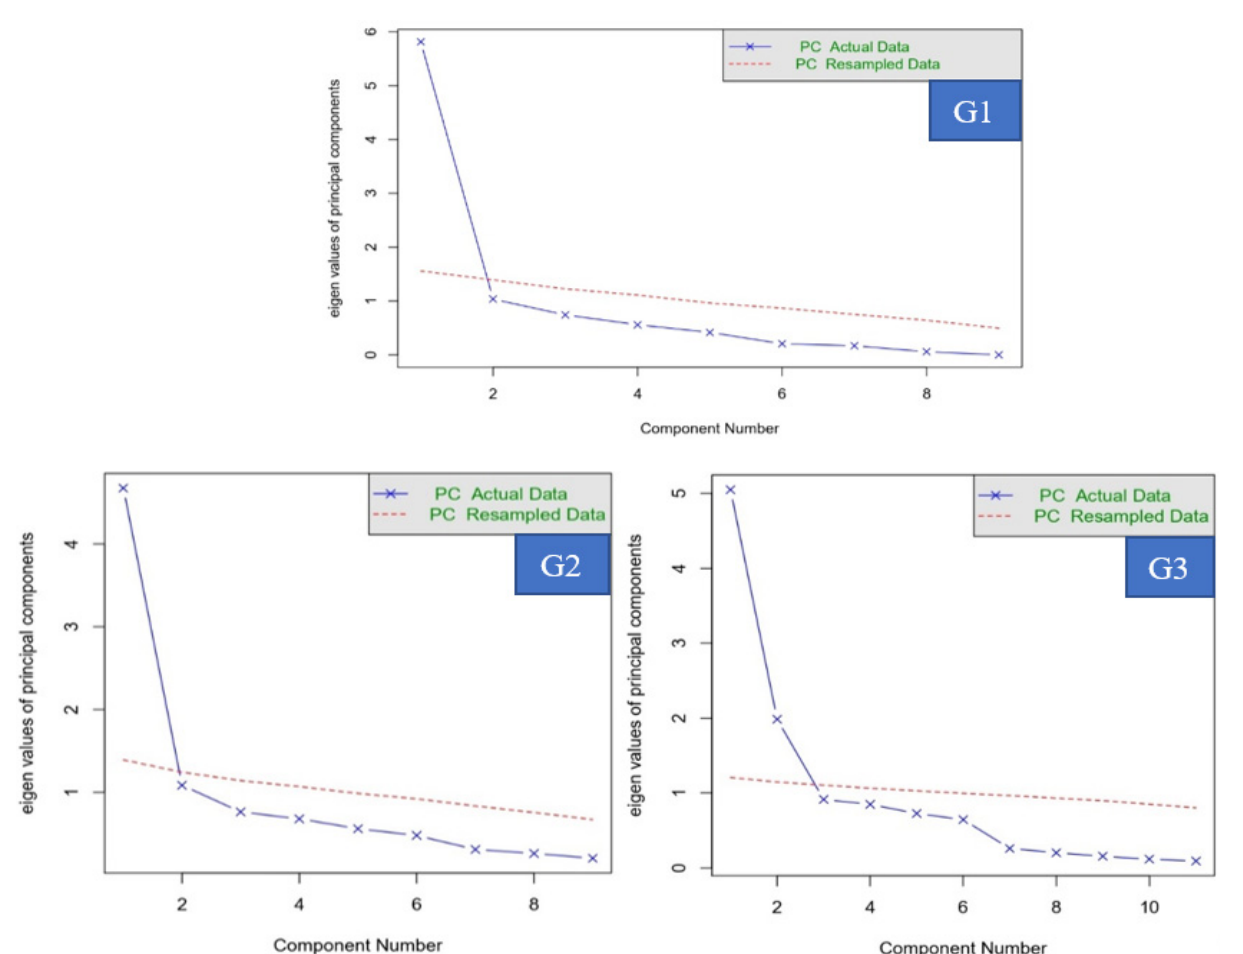
Figure 1. Parallel instrument analysis chart for the three groups.